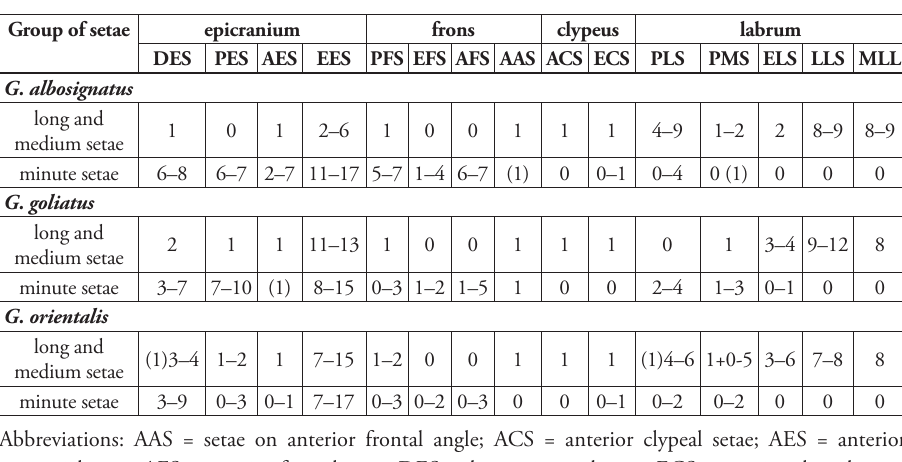
Table 1. Cranial chaetotaxy of G. albosignatus , G. goliatus, and G. orientalis